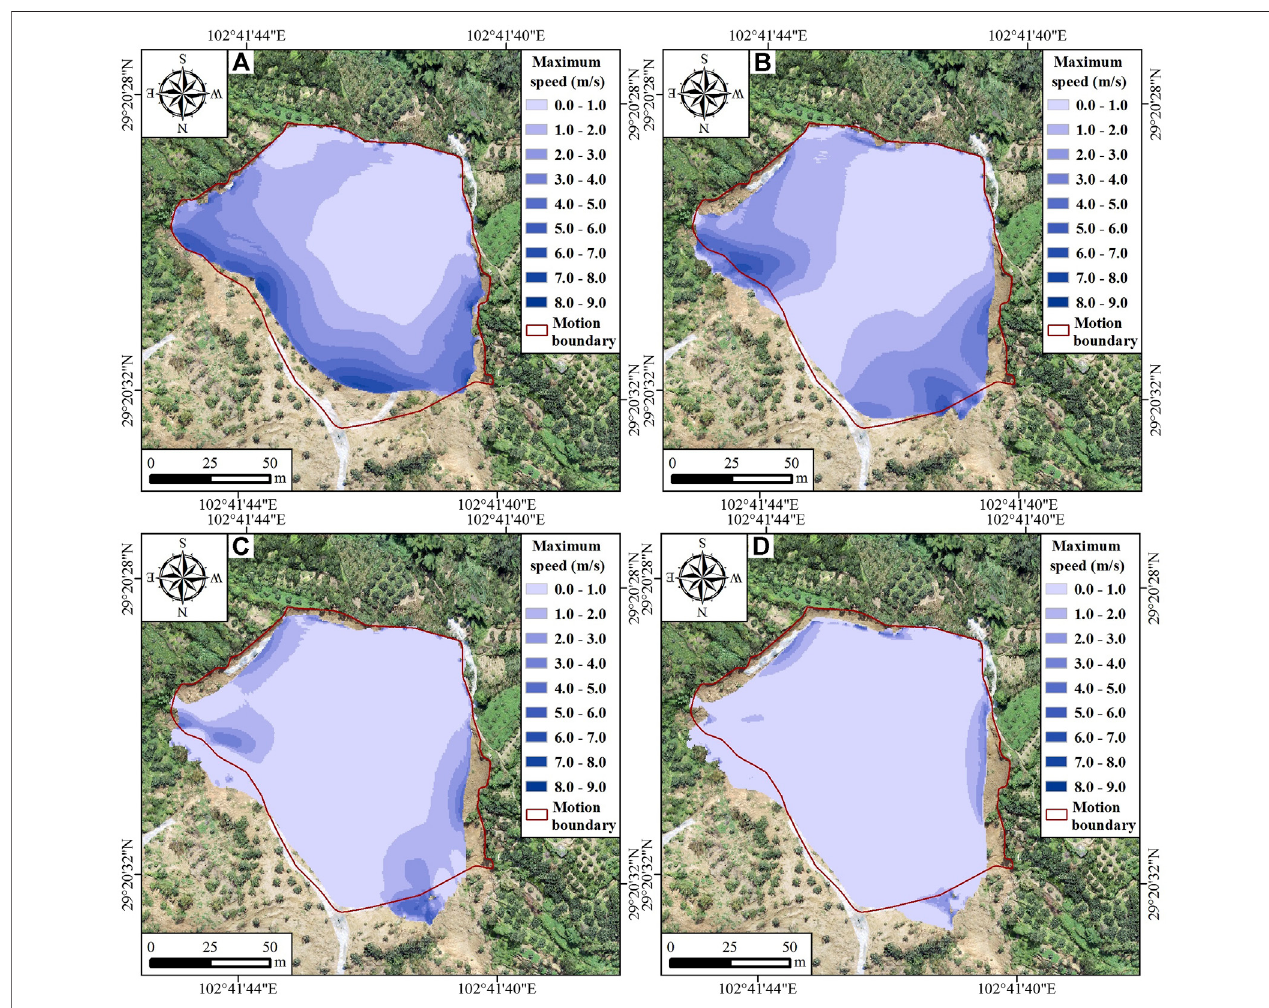
FIGURE 5 | Speed of the initial landslide at (A) t (cid:2) 2 s, (B) t (cid:2) 4 s, (C) t (cid:2) 6 s, and (D) t (cid:2) 8 s.